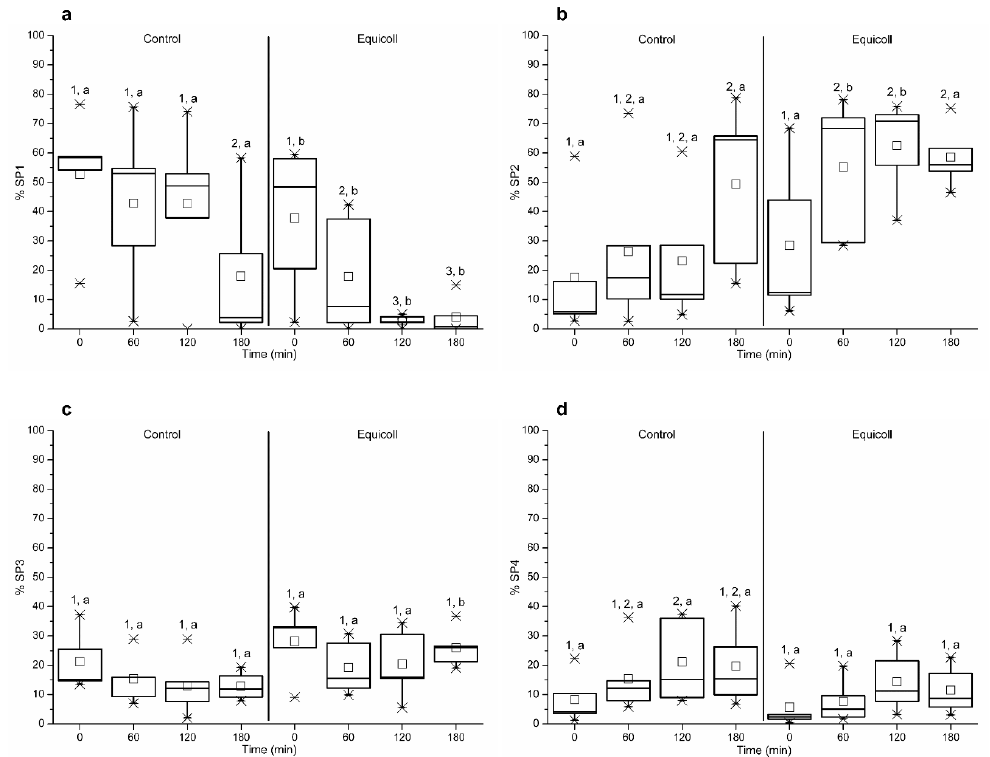
Figure 6. Proportions of spermatozoa belonging to one of each sperm subpopulations (( a ), SP1; ( b ), SP2; ( c ), SP3; ( d ), SP4) in control (non-selected samples) and SLC-selected samples (Equicoll). Di ff erent superscript letters (a, b) indicate significant di ff erences ( p ≤ 0.05) between treatments within a given time point, and di ff erent superscript numbers (1–3) mean significant di ff erences between time points within the control or samples selected with Equicoll. Data are shown as box-whisker plots for 10 separate experiments. SLC: single layer centrifugation. SP1: subpopulation 1; SP2: subpopulation